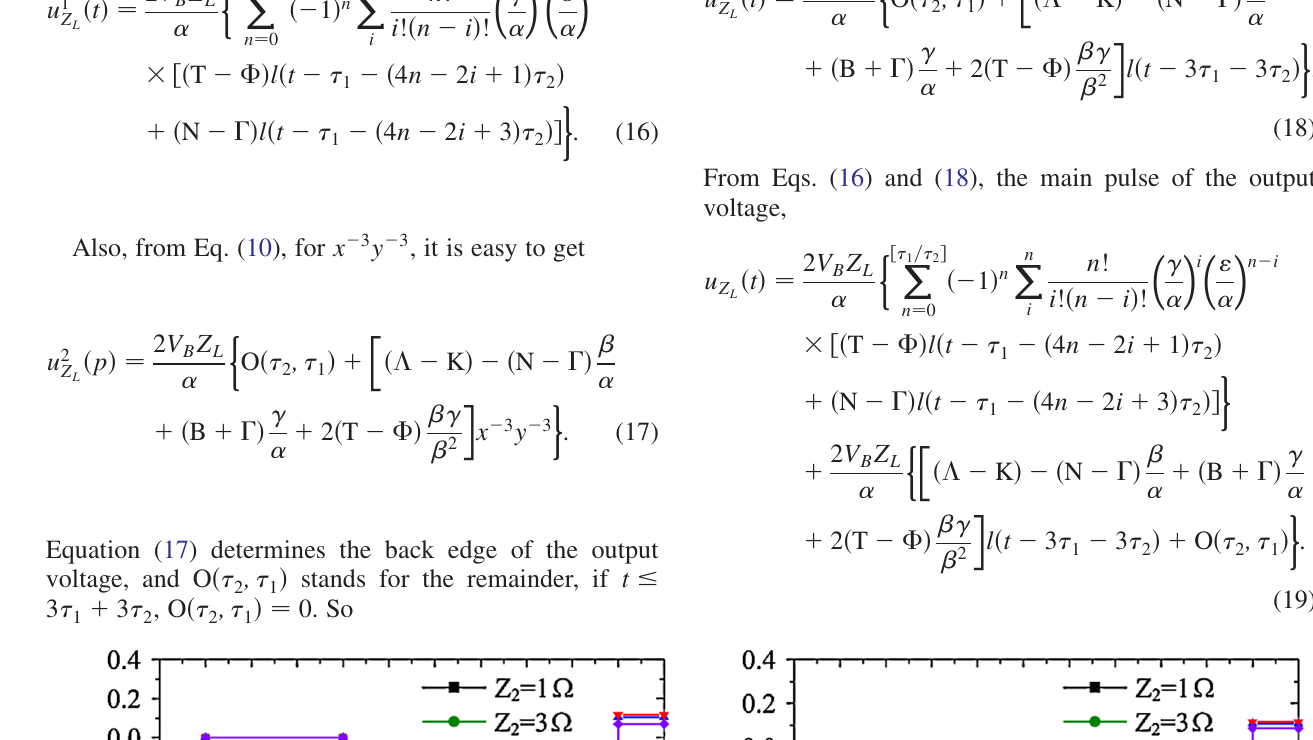
¼ 6 (cid:6) , Z ¼ 8 (cid:6) , Z ¼ 14 (cid:6) ; (d) Z 1 3 L